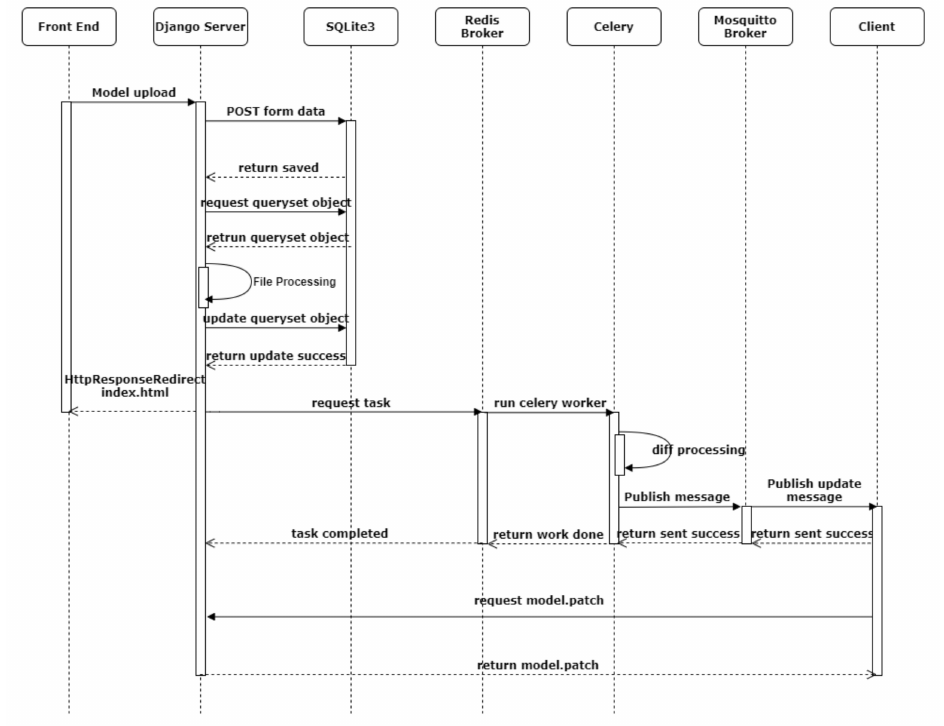
Figure 5. The detailed workflow of the neural network model publish process in the proposed collaborative edge computing